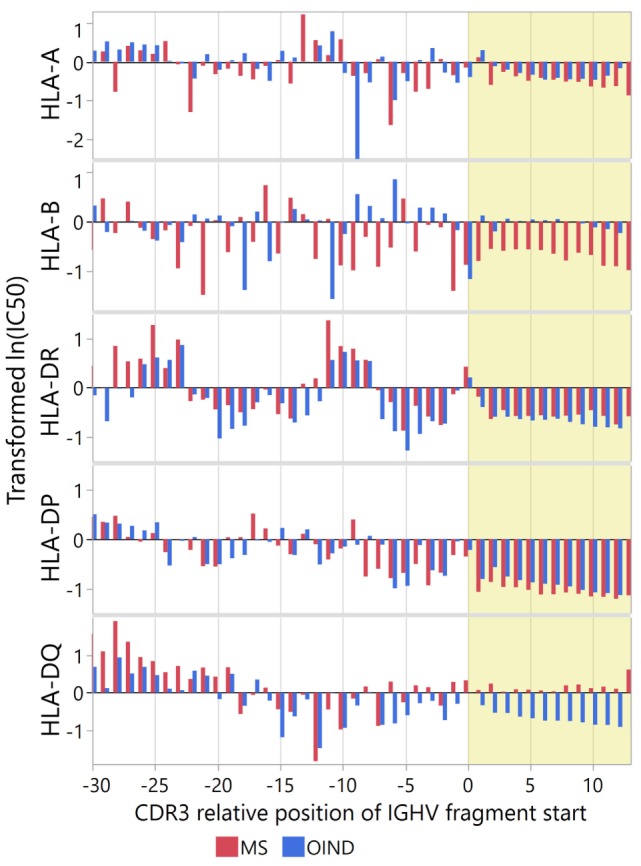
Immunoglobulin heavy chain variable (IGHV) fragment affinities for patient-specific human leukocyte antigen (HLA) molecules. Binding affinities of IGHV fragments were predicted for patient-specific HLA A, B, DP, DR, and DQ molecules (listed in Table 1). Results are presented as mean Johnson SI standardized values of ln(IC50) for each complementarity determining region 3 (CDR3) relative position, with low values indicating high affinity. For heterozygous patients with two sets of predictions for one HLA molecule, we used the lowest standardized ln(IC50). Yellow shade indicates the CDR3 region.